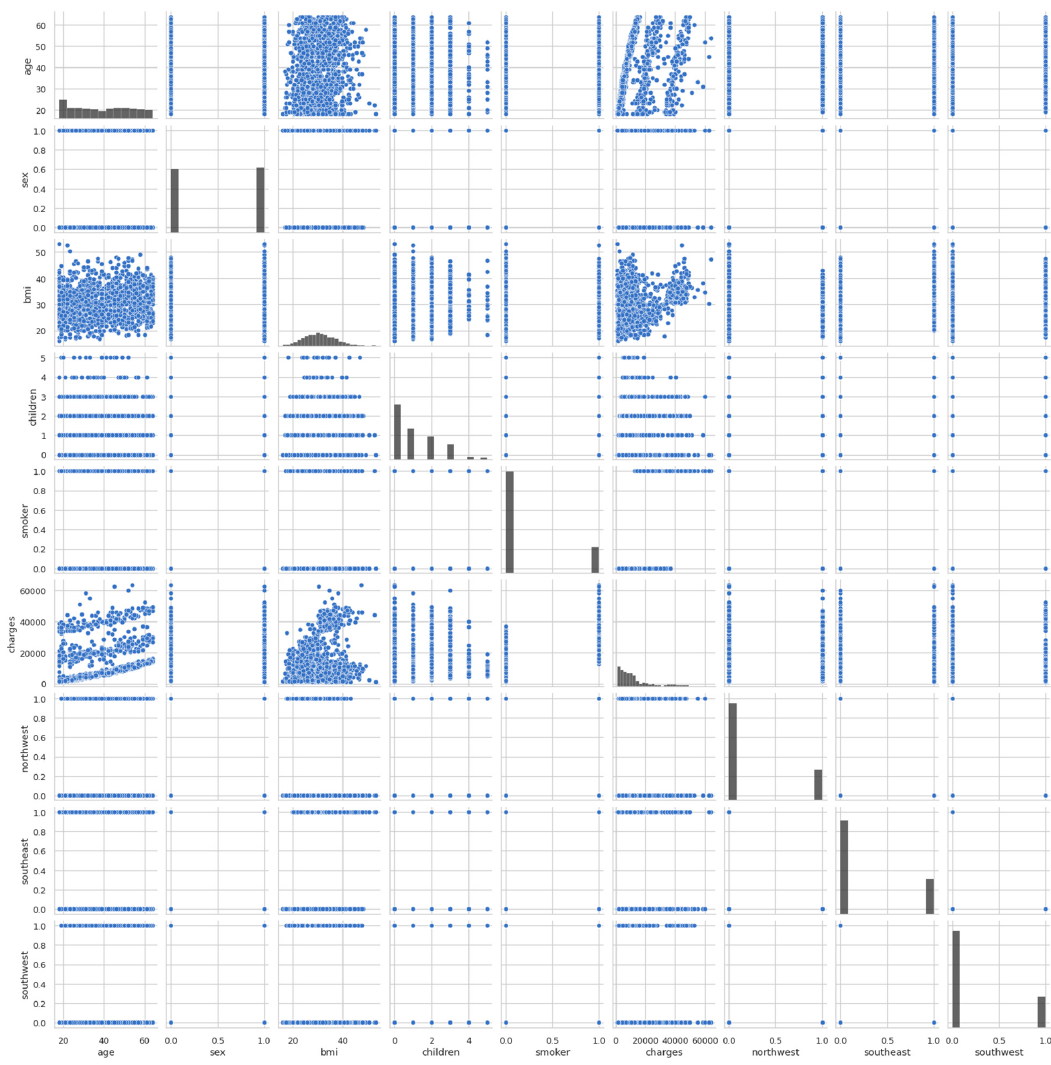
Figure 4. Pairplot diagram of entire dataset.